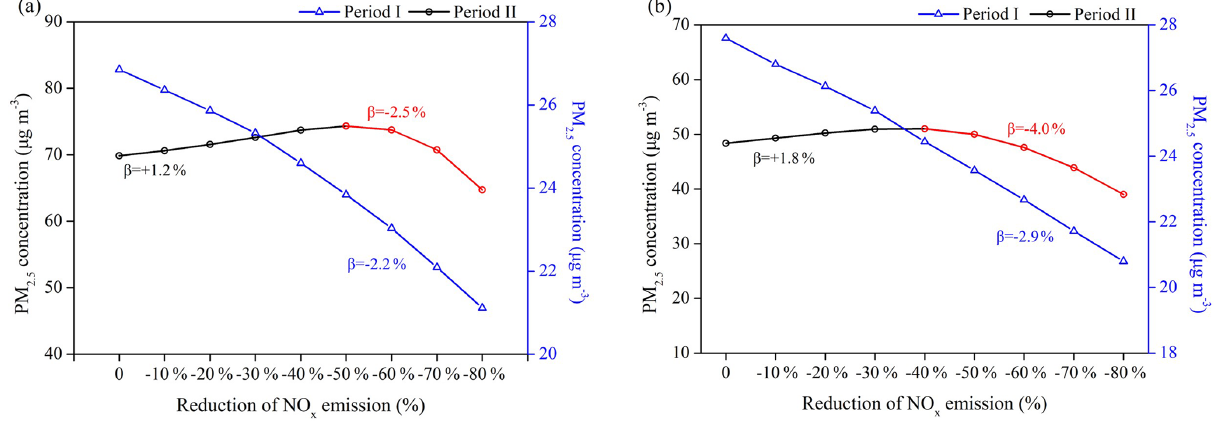
Figure 7. Responses of surface PM 2 . 5 concentrations to the NO x emission reduction scenarios in (a) BTH and (b) YRD. The calculated NO x emission control efficiency ( β ) is also marked in the figure.